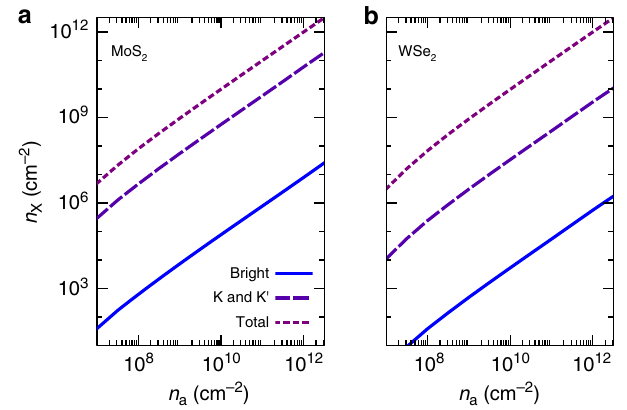
Fig. 3 Comparison of the relative importance of bright and dark excitons. The density of bright excitons that ful fi ll energy and momentum conservation in radiative recombination processes, the dark exciton density due to intra-valley excitations in the vicinity of K and K ’ , as well as the total exciton density vs. excitation density are shown for a MoS 2 and b WSe 2 on SiO 2 substrate at T = 300